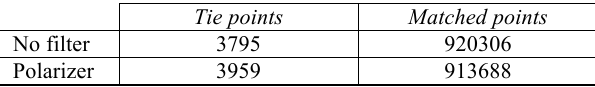
Table 2. Metallic object #1 (Patera). Orientation and matching results with and without polarizing filter.